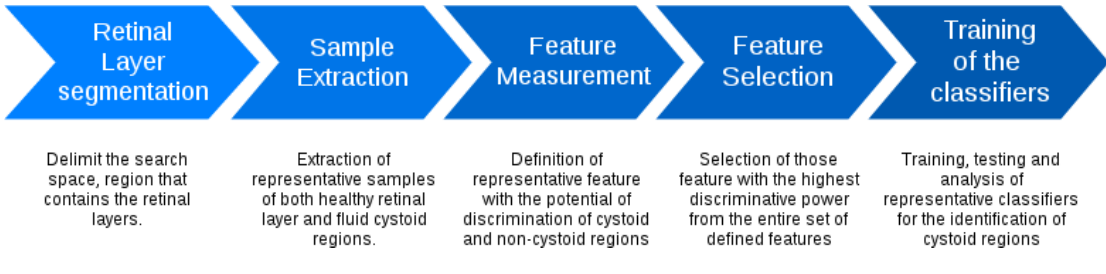
Figure 4. Main stages of the used methodology.